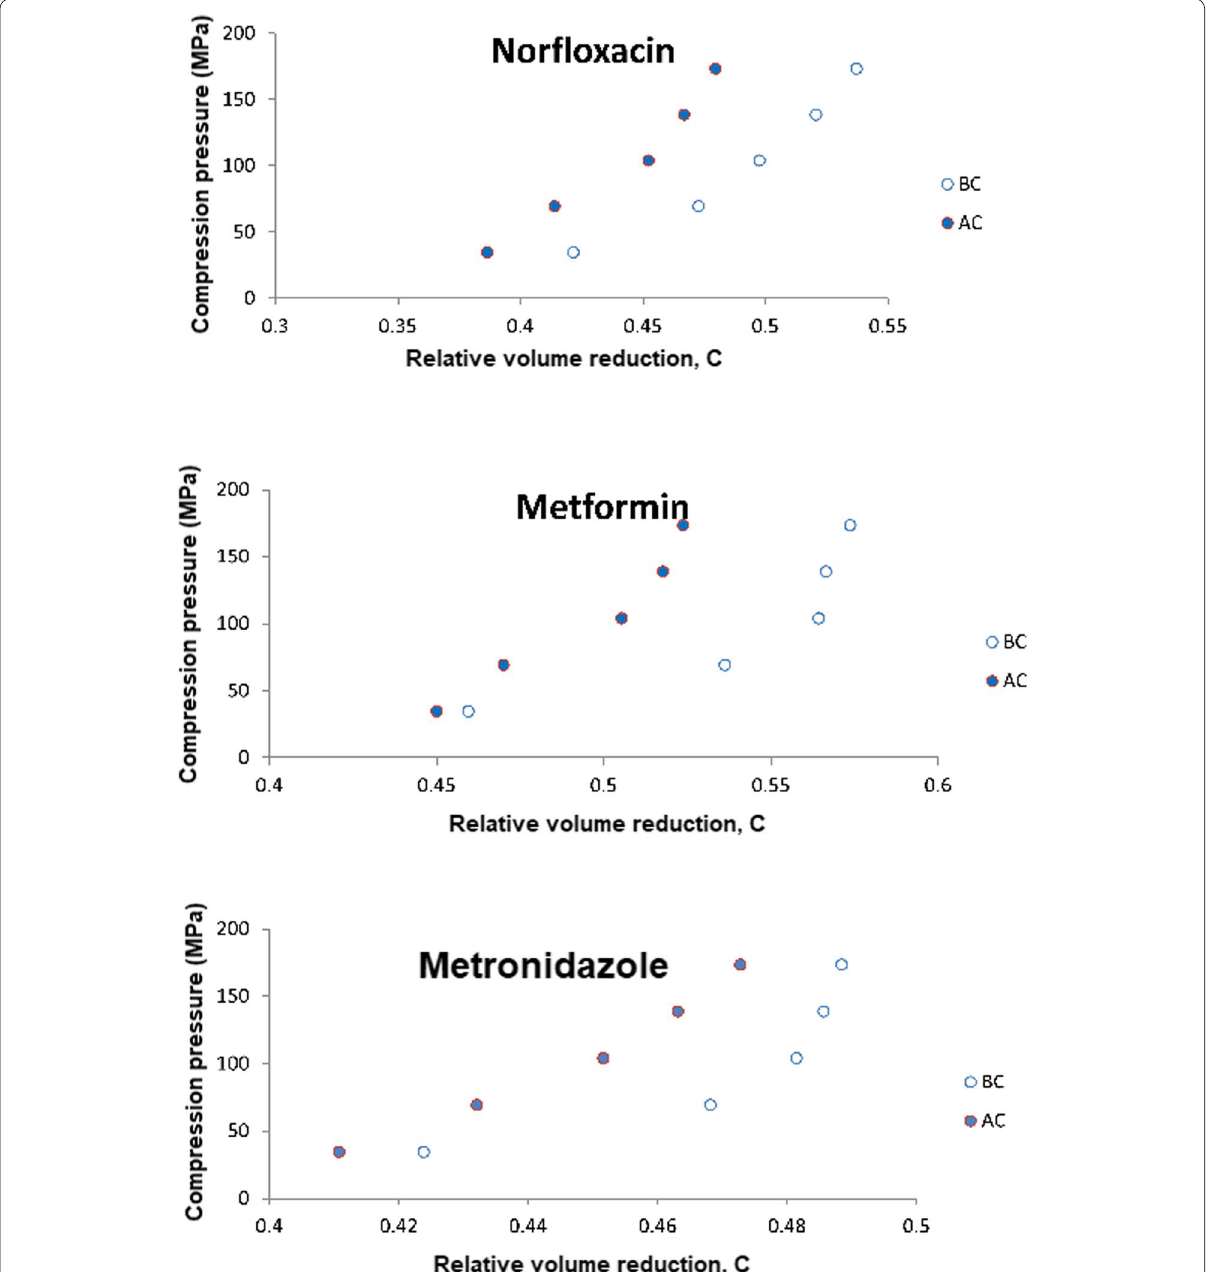
Fig. 6 The compression pressure-relative volume reduction relationship according to Eq. 2 applied to all non-compacted (BC) and compacted (AC) drugs comprising norfloxacin, metformin, and